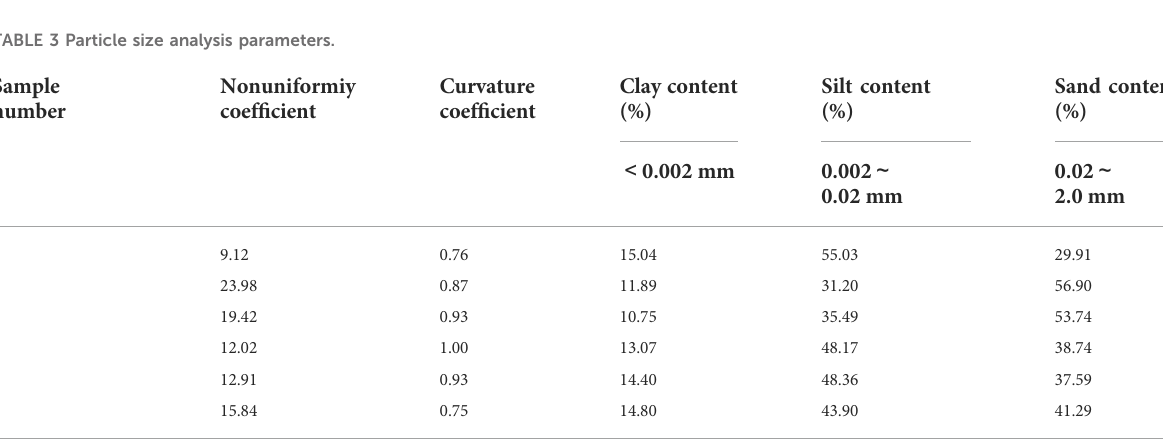
TABLE 3 Particle size analysis